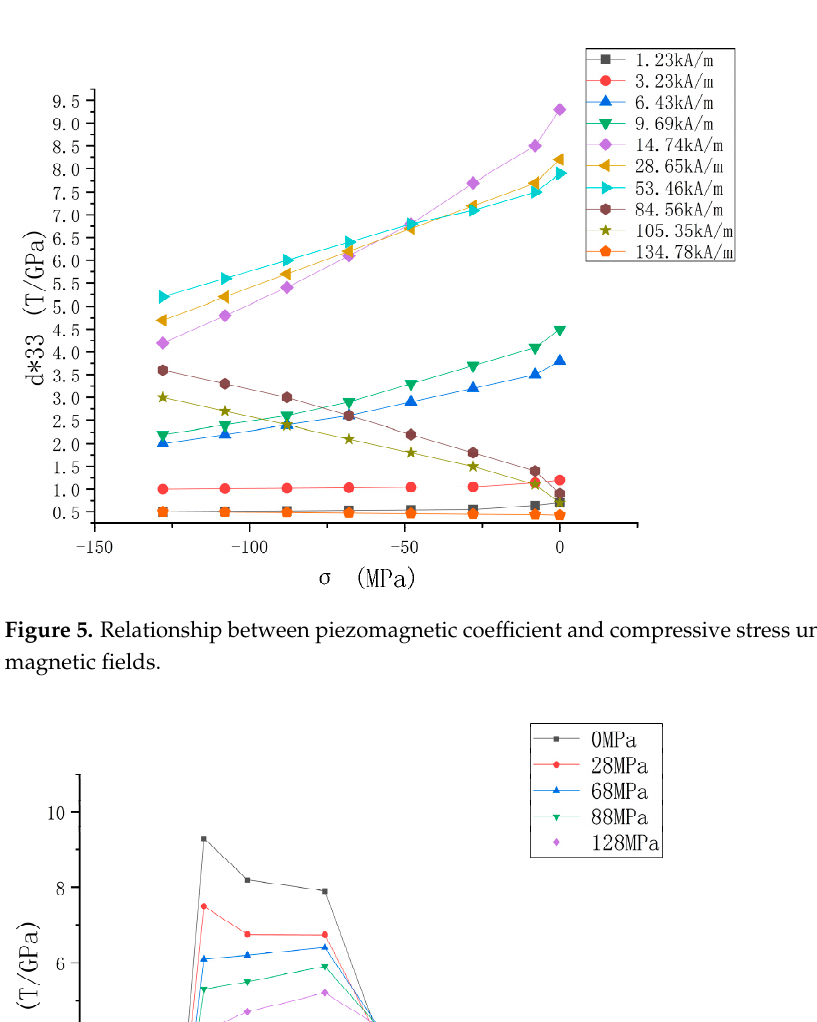
Figure 7. Variation diagram of magnetic domain under different magnetic induction intensity. ( a ) 105.35 kA/m. ( b ) 14.74 kA/m. 4. Design of Magnetostrictive Force Sensor 4.1. Sensor Structure According to the working conditions of the tractor lifter, referring to the KMB force sensor [29] on the market, a new piezomagnetic sensor, which is an improvement based on KMB, is designed by using iron-cobalt material to improve the defect that the KMB sensor can only receive one-directional force and has insufficient sensitivity. The sensor can be installed on the lifter through a suit. When the sensor is working, the external radial force along the sleeve acts on the sensor through the groove on the sleeve, and then the